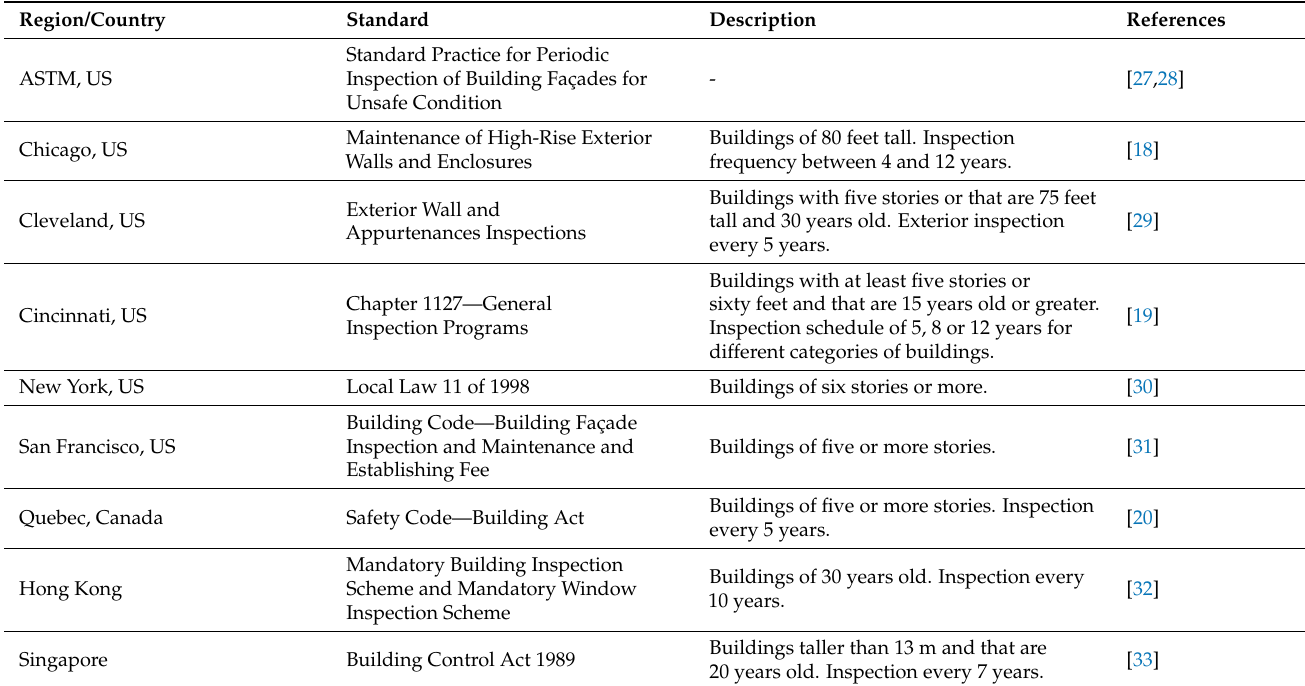
Table 2. Legislations worldwide for façade